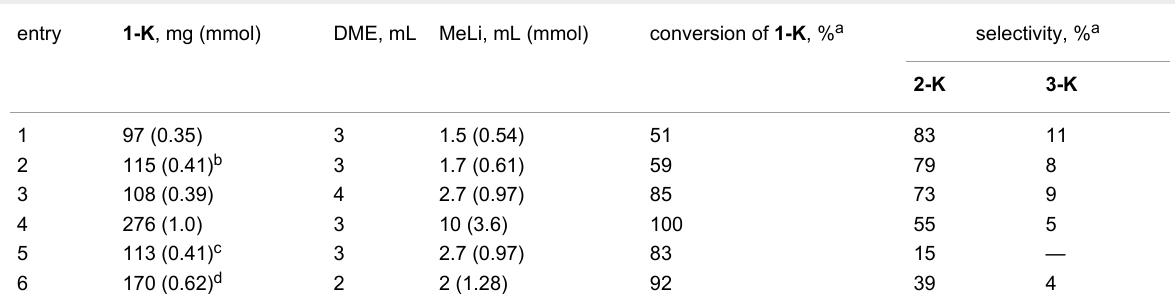
Table 1: Reaction of K[C 6 F 5 BF 3 ] ( 1-K ) with methyllithium (22 °C, 3 h). entry